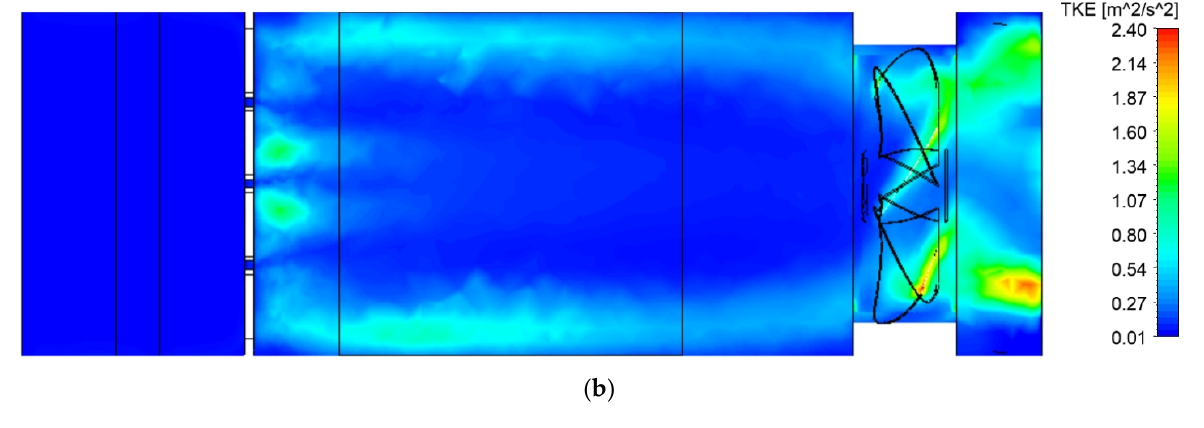
Figure 8. The ( a ) time ‐ averaged velocity magnitude and ( b ) turbulent kinetic energy fields at the mid ‐ vertical plane of the upper UVC chamber.